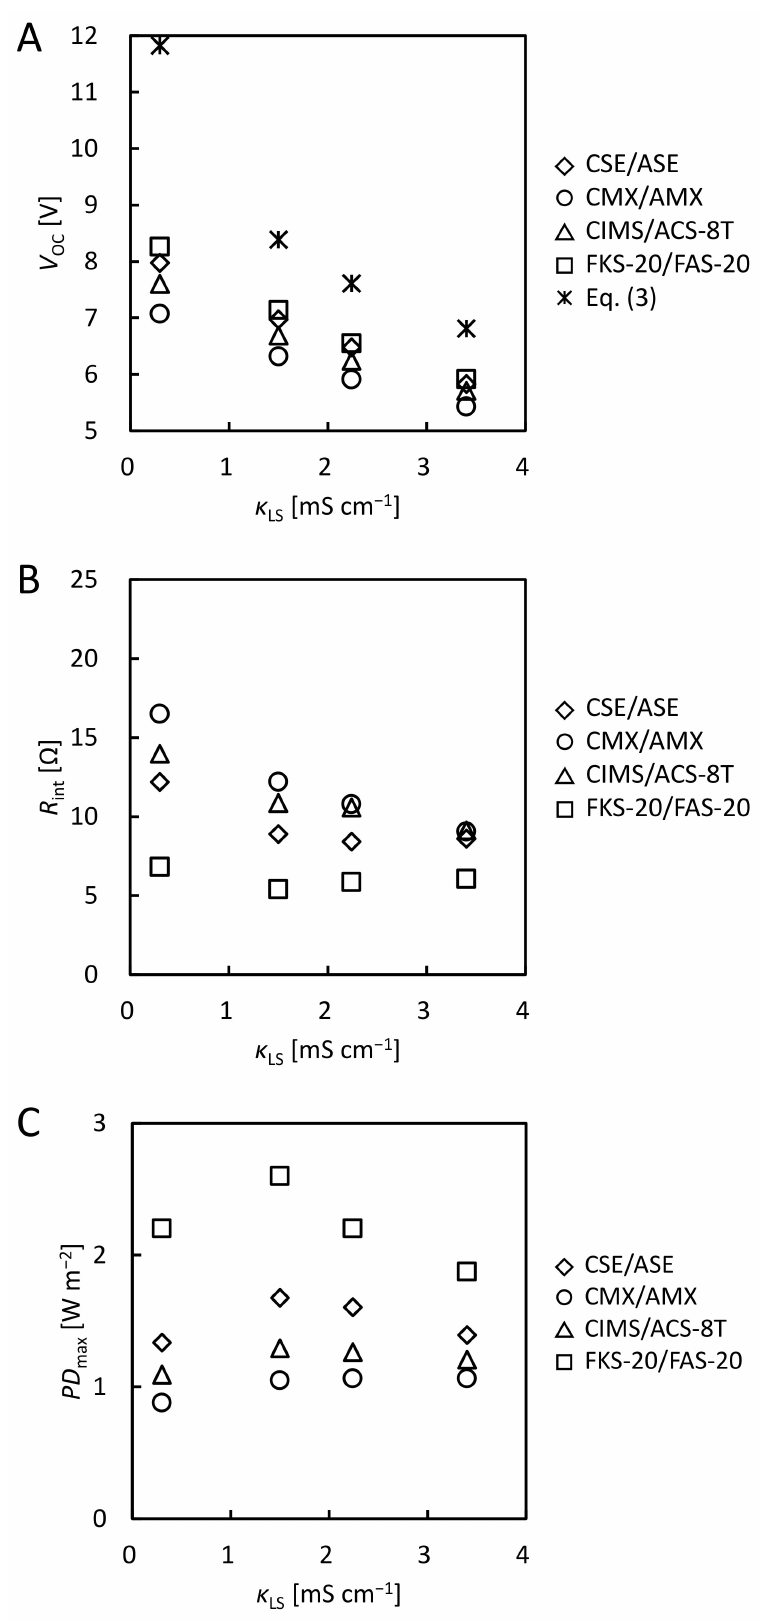
Figure 3. κ LS dependence of ( A ) V OC , ( B ) R int , and ( C ) PD max using model RO brine (90 mS cm − 1 NaCl) as HS and model RW as